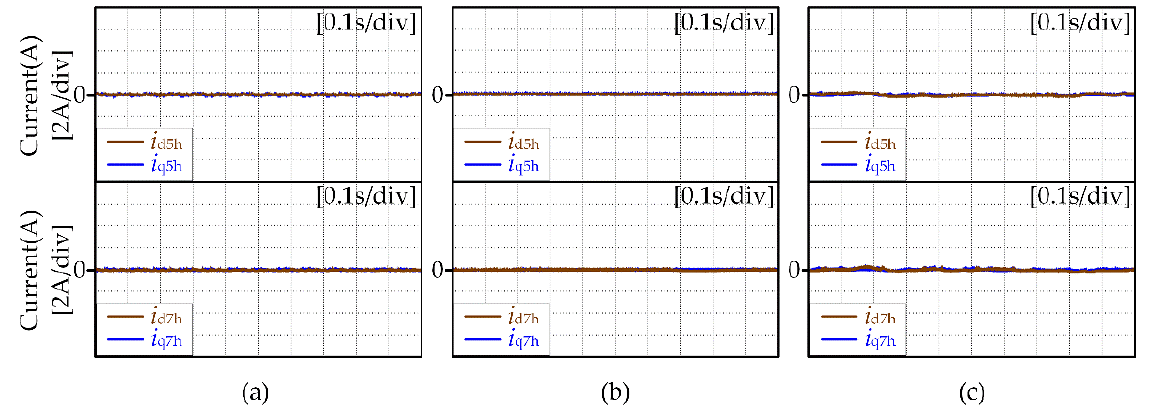
Figure 19. The steady-state waveform diagram of the 5th and 7th current harmonic components when the motor parameters change by 1.2 times. ( a ) 100 rpm; ( b ) 1000 rpm; and ( c ) 2500 rpm.